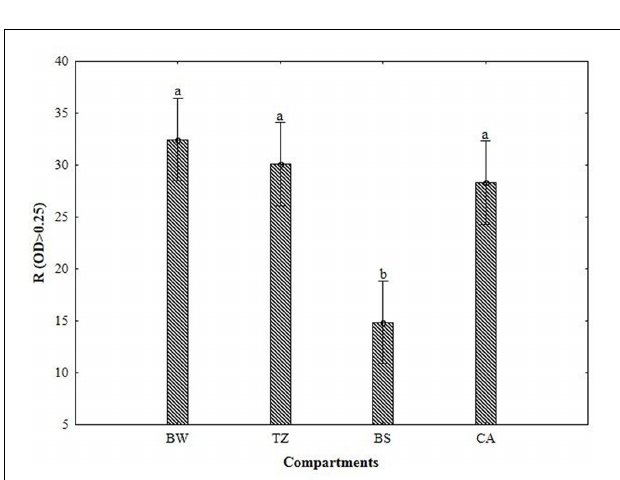
FIGURE 3 | Richness index (R) of metabolized substrates calculated from Biolog data for different compartments of burrow system (BW, burrow wall; TZ, transitional zone; BS, bulk soil; CA, cast aggregates). Error bars represent 0.95 confidence intervals. The different letters indicate significant differences between the compartments at P <